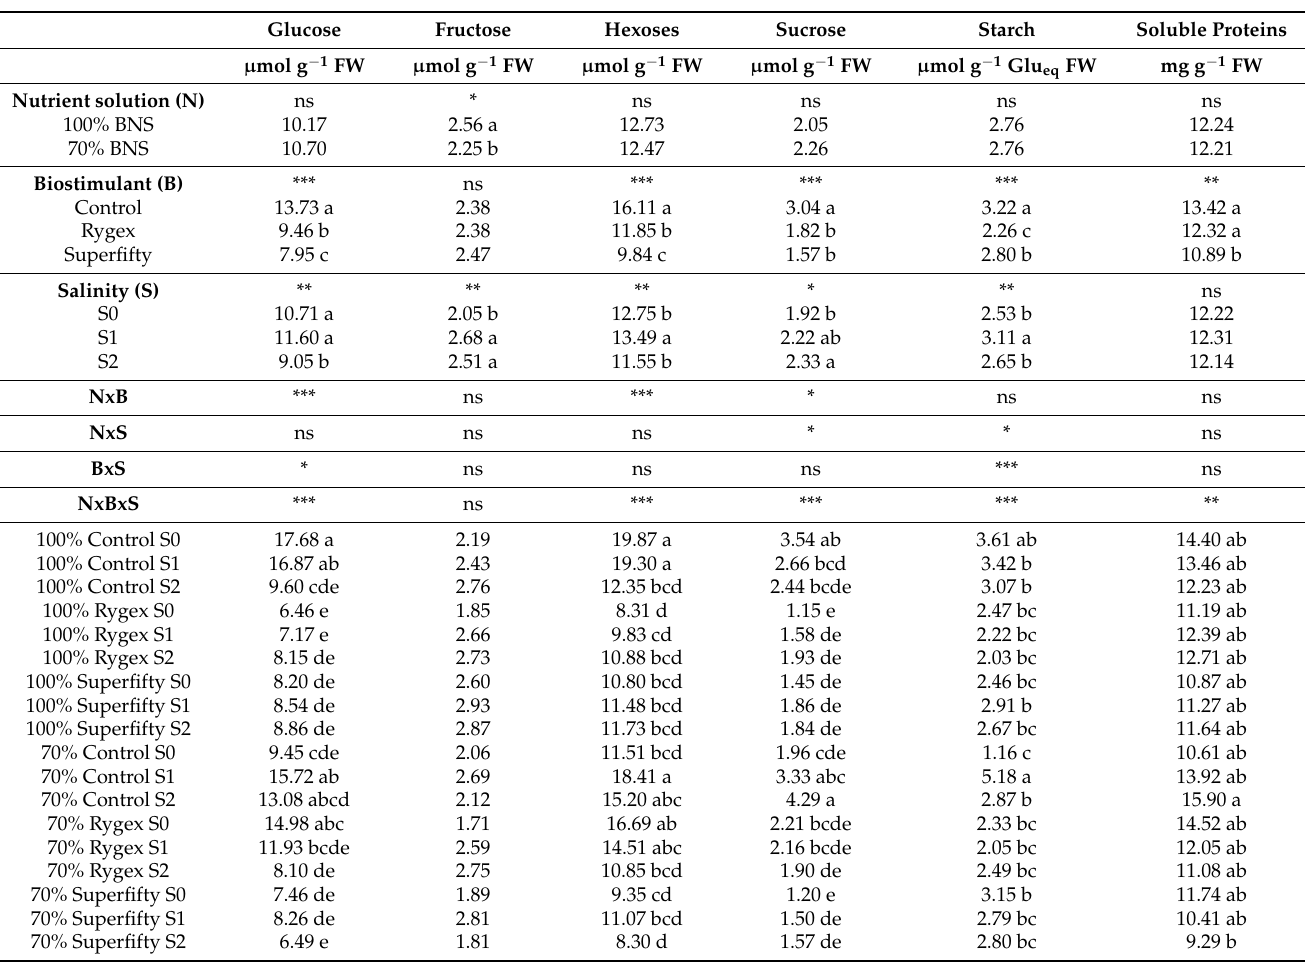
Table 4. Significance of the main factors (nutrient solution, biostimulant and salinity) and their interactions on content of glucose, fructose, sucrose, starch, hexoses and soluble proteins in leaves of MicroTom plants. Experimental design is as in Table 1. Glucose Fructose Hexoses Sucrose Starch Soluble